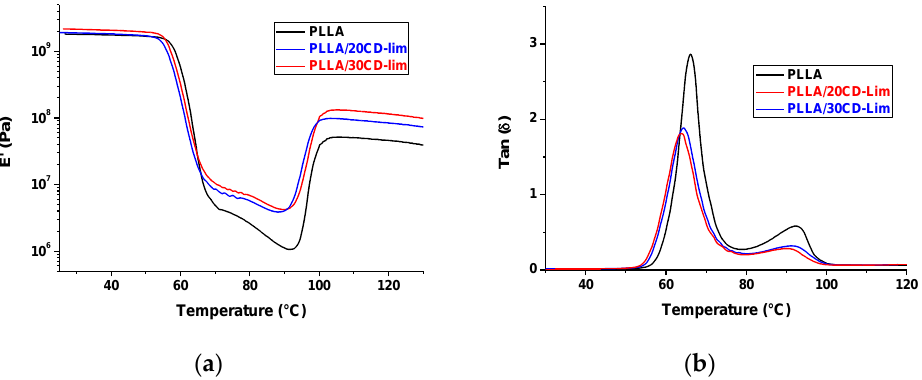
Figure 5. Storage modulus (E′) ( a ) and damping factor (tan δ) ( b ) vs. temperature of PLLA and PLLA/CD-Lim composites at a heating rate of 2 °C min −1 and frequency of 1 Hz. Cold crystallization has an anticipated onset in the composites compared to the plain polymer, which corroborates the knowledge gained by DSC analysis. The onset of crys- tallization was measured at about 90 °C by DMA upon heating at 2 °C min −1 (Figure 5a) and at about 100 °C by DSC upon heating at 10 °C min −1 (Figure 4a). The lower heating rate in DMA allows more time for chain ordering, favoring crystal nucleation and growth at lower temperatures, which results in an anticipated onset of cold crystallization [47]. After completion of crystallization, the storage modulus appeared to be sizably affected by the filler′s presence, as it increases with CD-Lim content. This effect is not seen at low temperatures below T g , where only minor differences in E ′ values could be measured. At low temperatures, the plasticizing effect of limonene on PLLA matrix counterbalances the raised stiffness due to the presence of the filler. Upon heating, the small amount of D - limonene dissolved in PLLA evaporates, and only the reinforcing effect of the filler re- mains, causing sizable variation in the storage modulus with composition. 4. Conclusions Composites prepared with PLLA and β-cyclodextrin containing D -limonene, all bio- based, were produced via twin-screw extrusion in different compositions. Encapsulation of D -limonene within β-cyclodextrin cavities greatly enhances the thermal stability of the essential oil to a level that allows its melt processing with PLLA, without marked loss of the essential oil. The results detailed above demonstrate that this is a successful strategy to incorporate D -limonene within PLLA via melt processing. The composite films are slightly plasticized by small amounts (about 1.5 wt%) of D - limonene released from the β-CD cages upon melt processing. CD-Lim filler affects crys- tallization kinetics of PLLA, acting as an efficient nucleating agent, able to promote PLLA crystals growth. All formulations have comparable stiffness at room temperature, which varies with filler content at temperatures above T g . Morphological analysis of the cryo- genically fractured samples display a homogeneous distribution of the filler within PLLA, with limited agglomeration observed only at high filler content. Moreover, the filler par- ticles seem to have a good level of adhesion to the PLLA matrix. The changes in thermal and thermo-mechanical properties and structure, detailed herein, largely influence tensile behavior as well as barrier and optical properties of the PLLA/CD-Lim composites, with results detailed in a submitted manuscript [28]. More im- portantly, it was proved that the obtained composites have antimicrobial properties, since when PLLA-CD-Lim films are put in contact with a wide range of bacteria and fungi, they